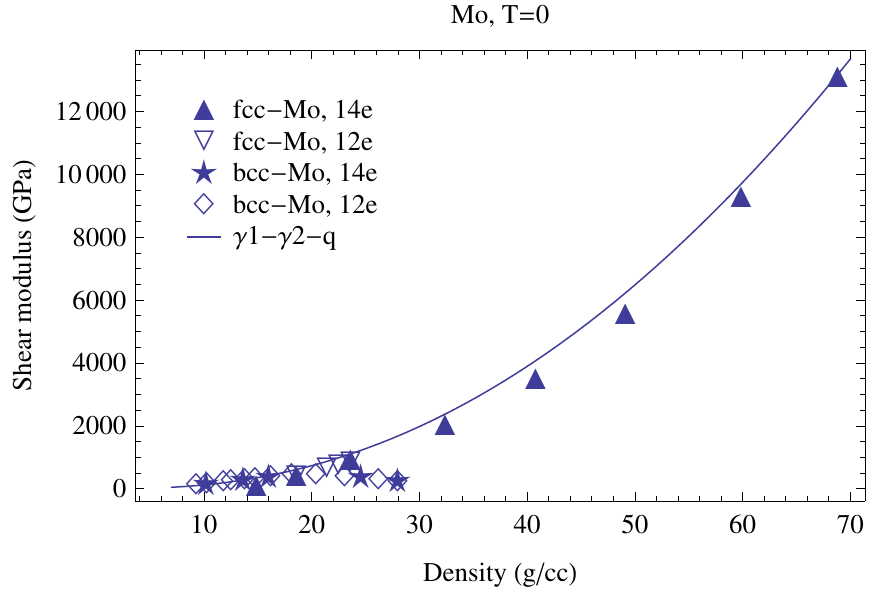
Figure 5. The T = 0 shear modulus of Mo: the unified analytic model ( γ 1 - γ 2 - q ) vs. ab initio calculations using VASP. 12e and 14e distinguish between the results obtained with 12 and 14 valence electrons,